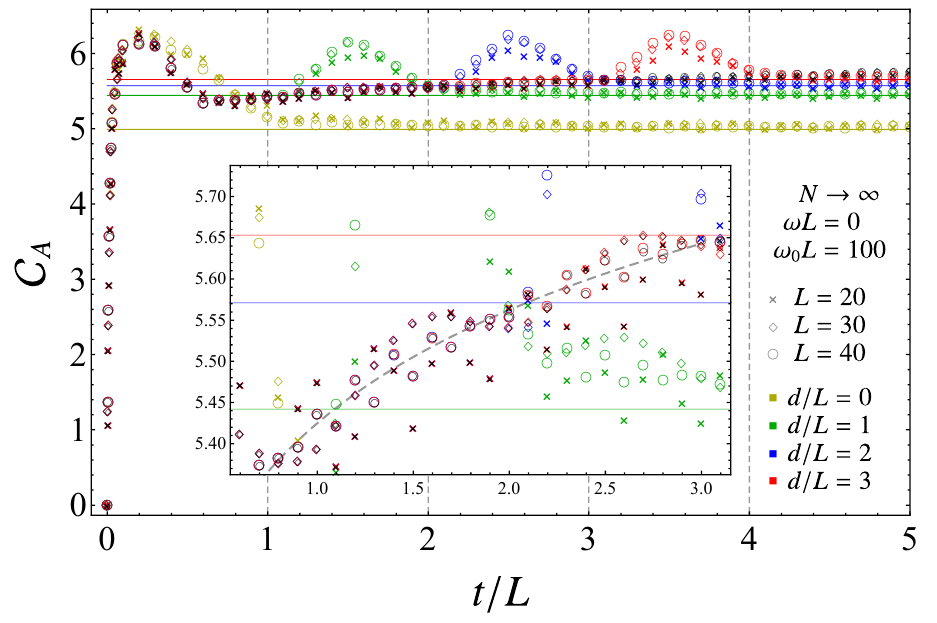
Figure 16 . Temporal evolution of C A after a global quantum quench with a gapless evolution Hamiltonian and ω 0 L = 100 , in the same setups of figure 14. The inset zooms in on the intermediate temporal regime between the two local maxima for the data having d/L = 3 .